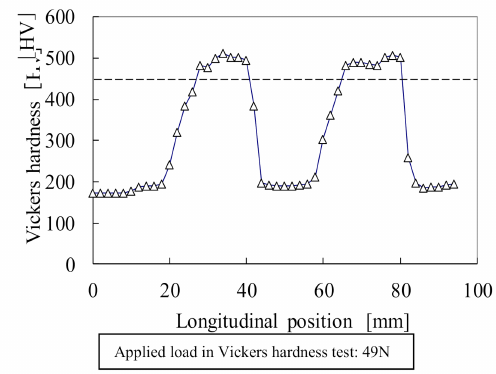
Figure 8. Longitudinal hardness distribution of the partially quenched straight product.